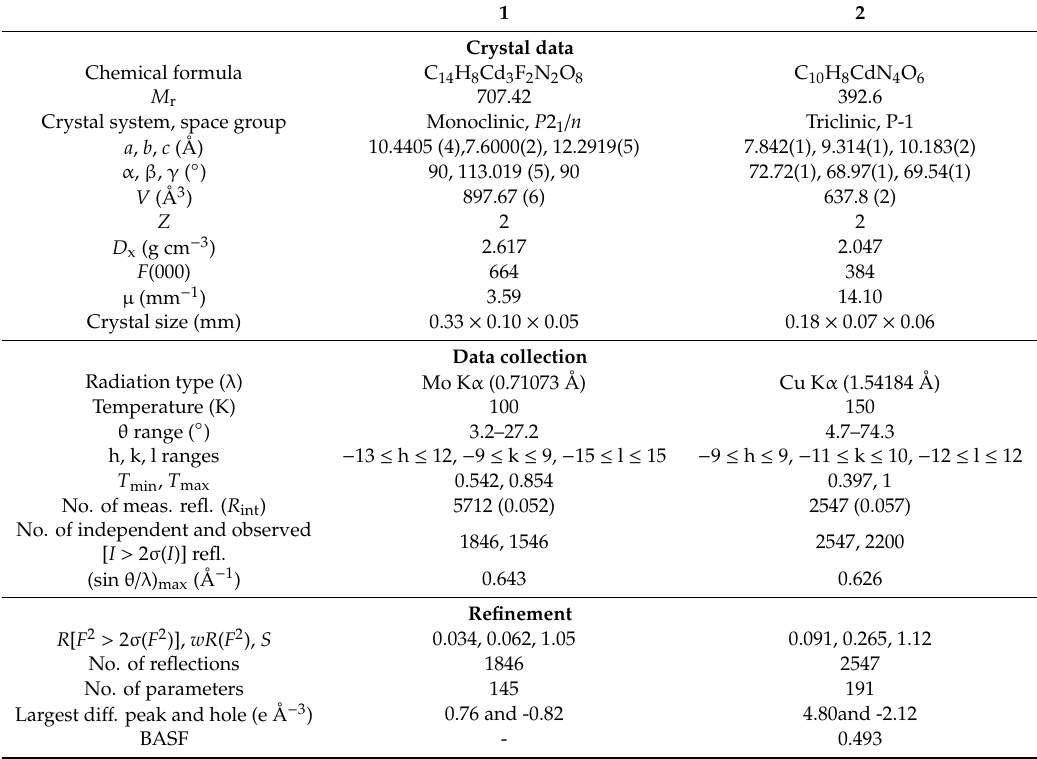
Table 1. Crystal data, data collection and structure refinement details for 1 and 2